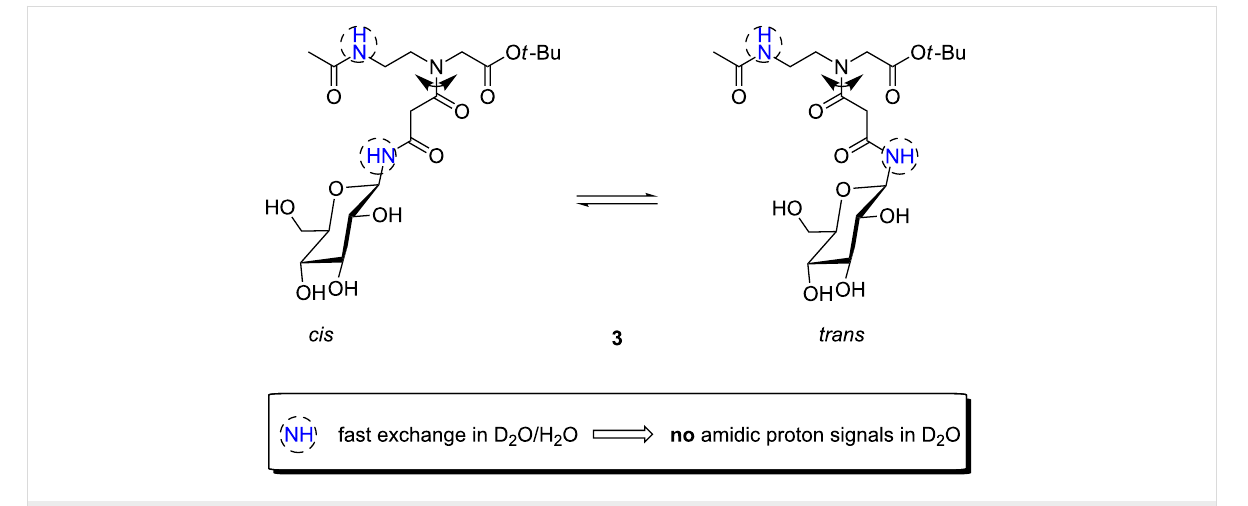
Figure 2: cis - and trans rotamer of unprotected PNA-building block 3